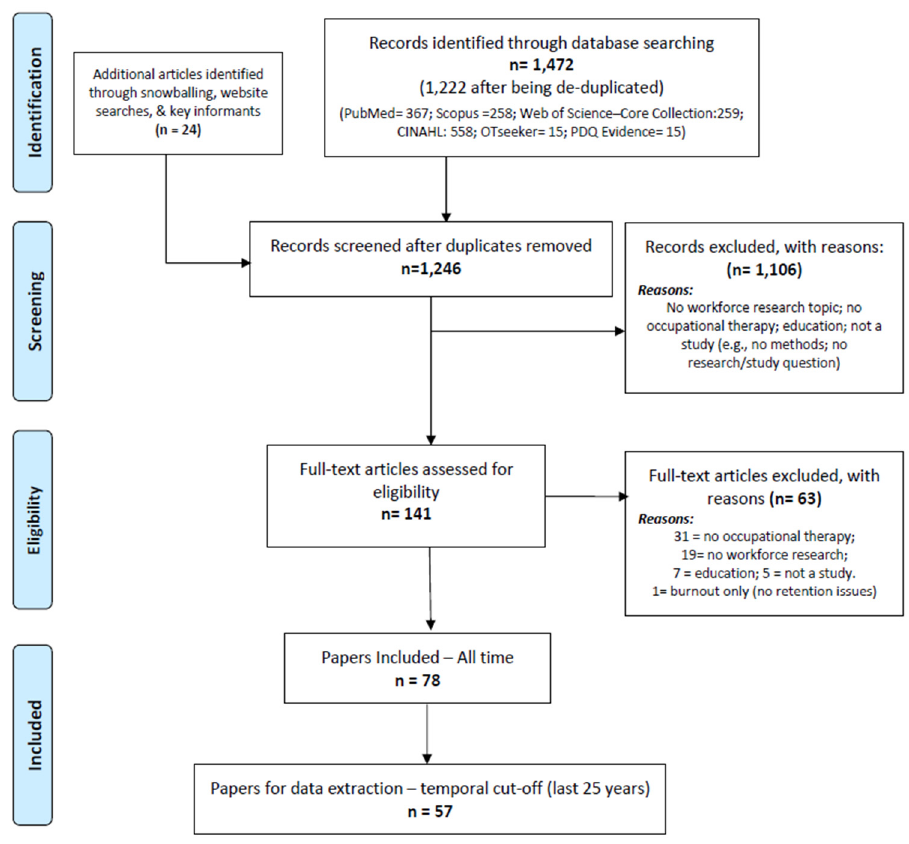
Figure 1. PRISMA flowchart of the scoping Figure 1 . PRISMA flowchart of the scoping review.